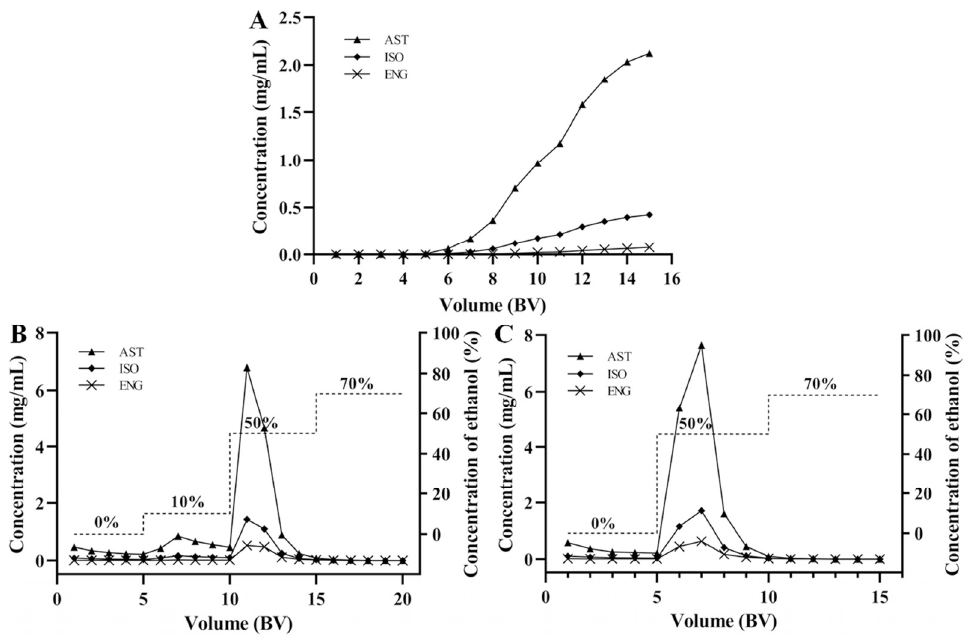
Figure 5. Dynamic leakage curves of the three flavonoids ( A ); dynamic desorption curves 1 ( B ) and 2 ( C ) of AST, ISO, and ENG.